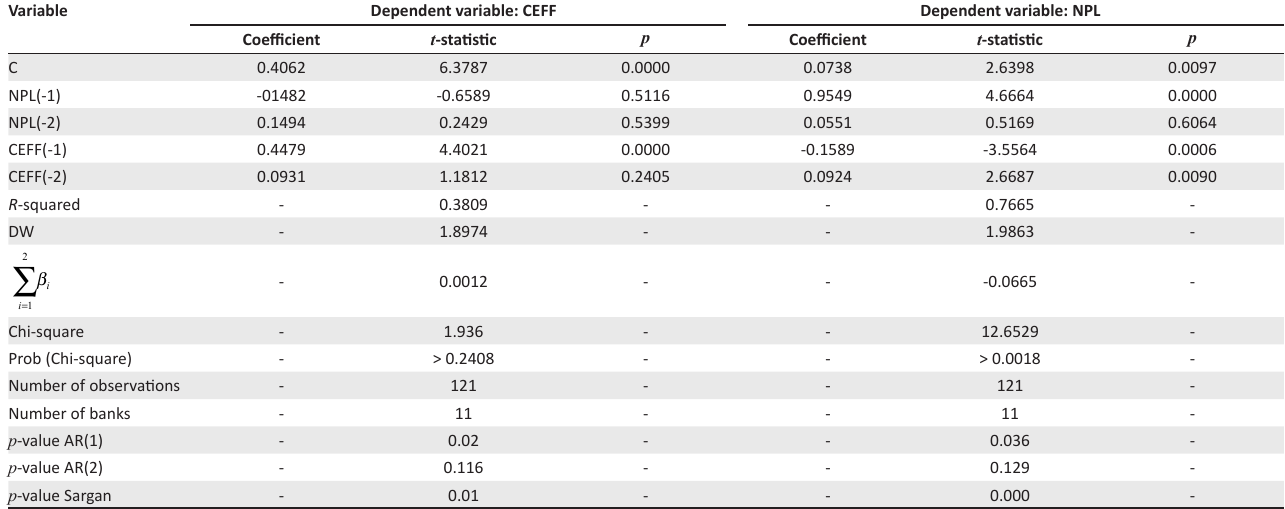
TABLE 1: Causality test between cost efficiency and non-performing loans.